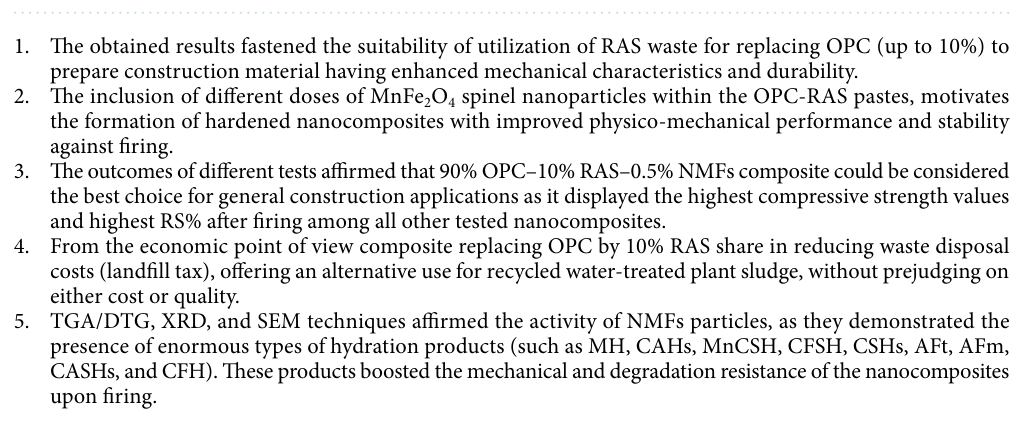
Figure 19. SEM micrographs of hardened specimens made from mix A: ( a ) after 7 days, ( b ) after 28 days, ( c ) after firing at 300 °C and ( d ) after firing at 800